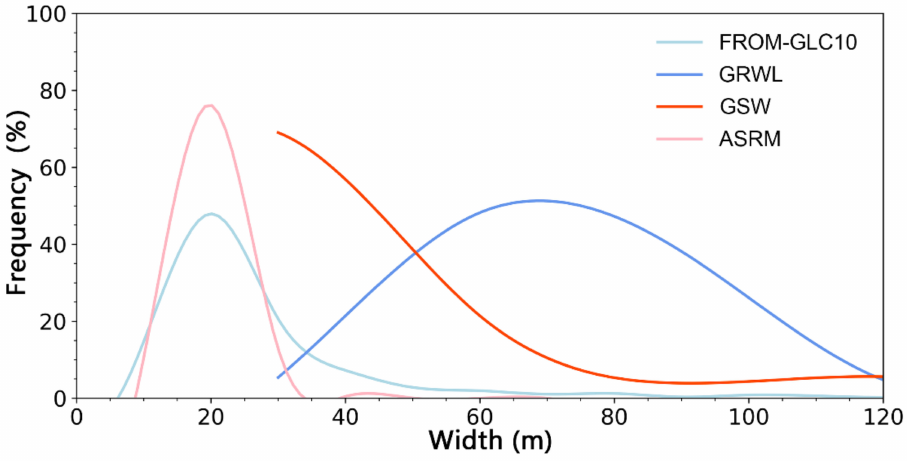
Figure 13. Comparison of ASRM with other data products on river